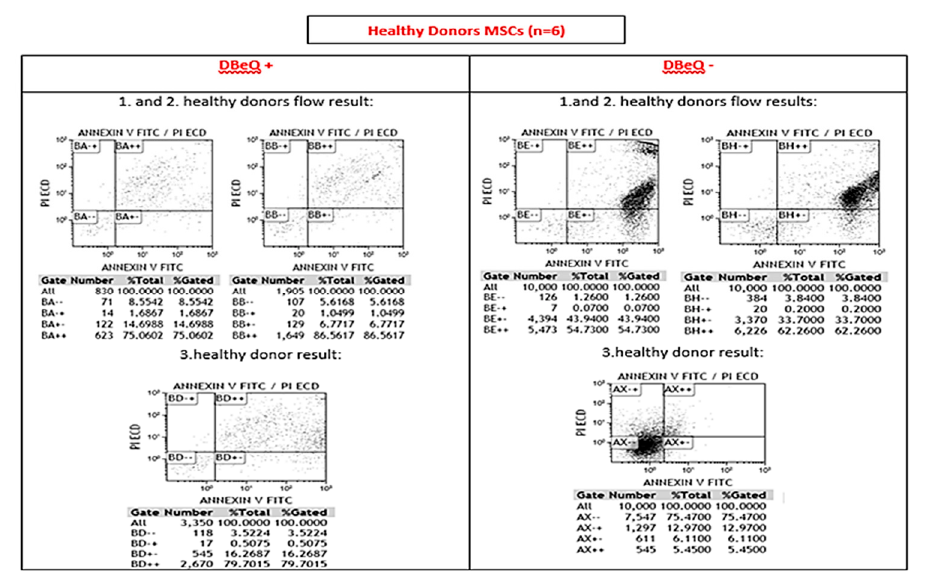
Figure 2. This figure is showed flow analysis results of healthy donor